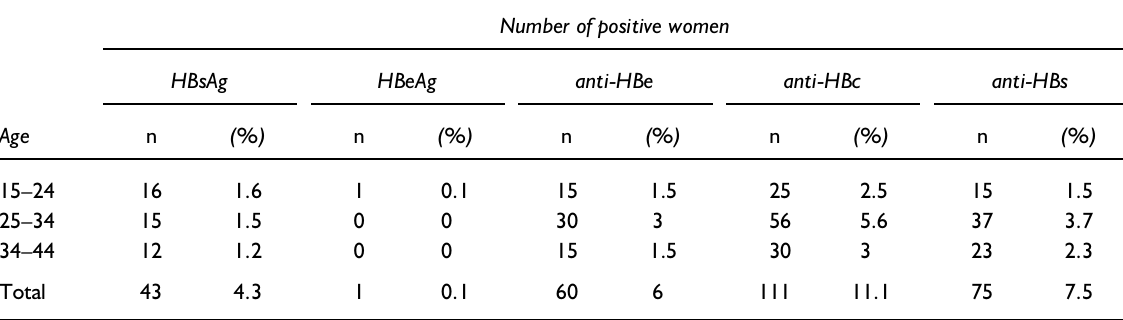
Table 1 Seroprevalence of HBV markers in pregnant Jordanian women by